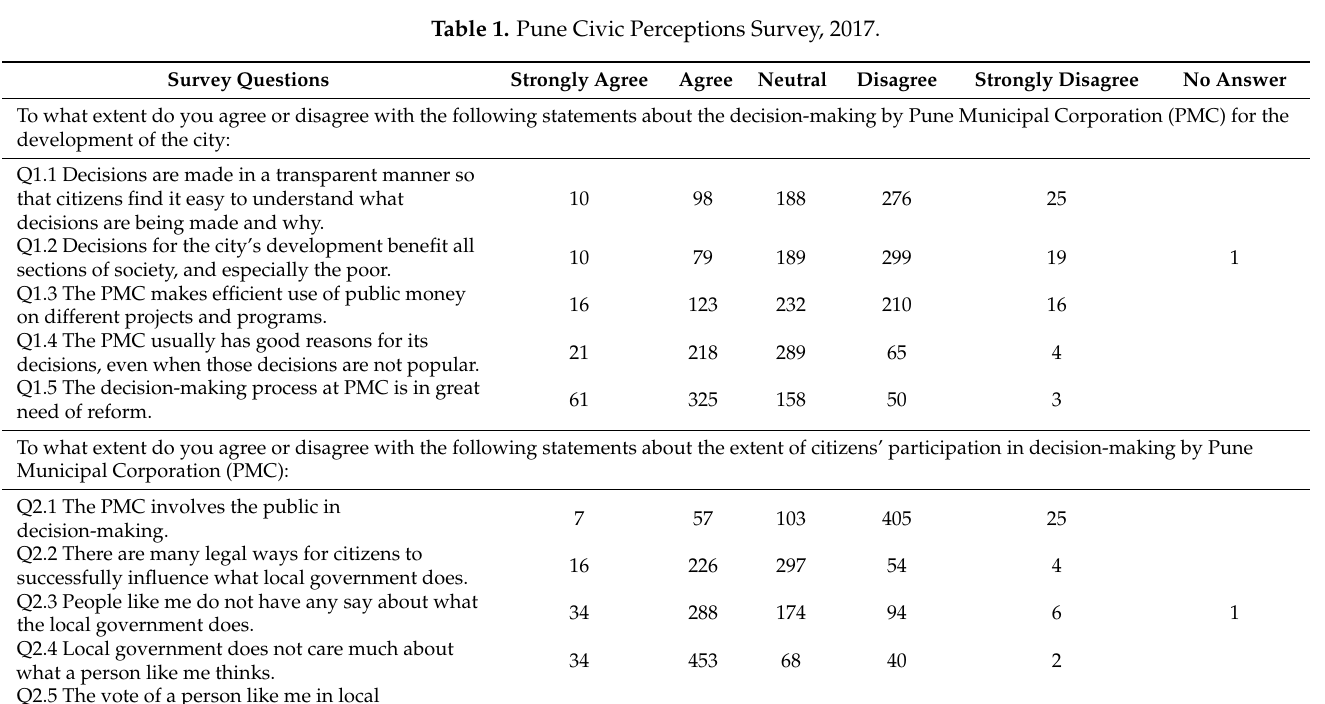
Table 1. Pune Civic Perceptions Survey,